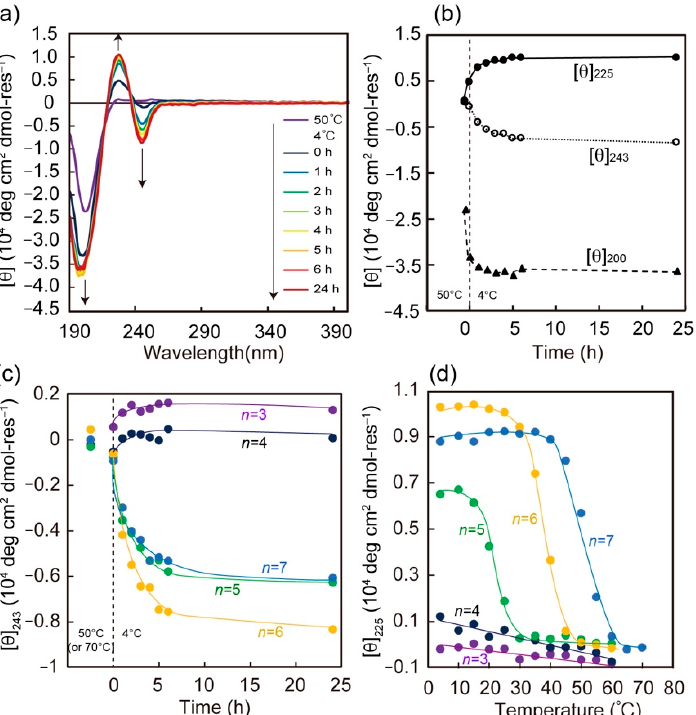
Figure 2. ( a ) CD spectral change of 2Np-CMP 6 in water (5% TFE) upon incubation at 4 °C after treatment at 50 °C (denatured form). ( b ) Time dependence of [ θ ] 200 , [ θ ] 225 and [ θ ] 243 values for aqueous 2Np-CMP 6 at 4 °C. ( c ) Time dependence of [ θ ] 243 value for 2Np-CMP n ( n = 3–7). ( d ) Temperature dependence of [ θ ] 225 value of 2Np-CMP n ( n = 3–7) in water (5% TFE). [2Np-CMP n ] = 60 μ M.